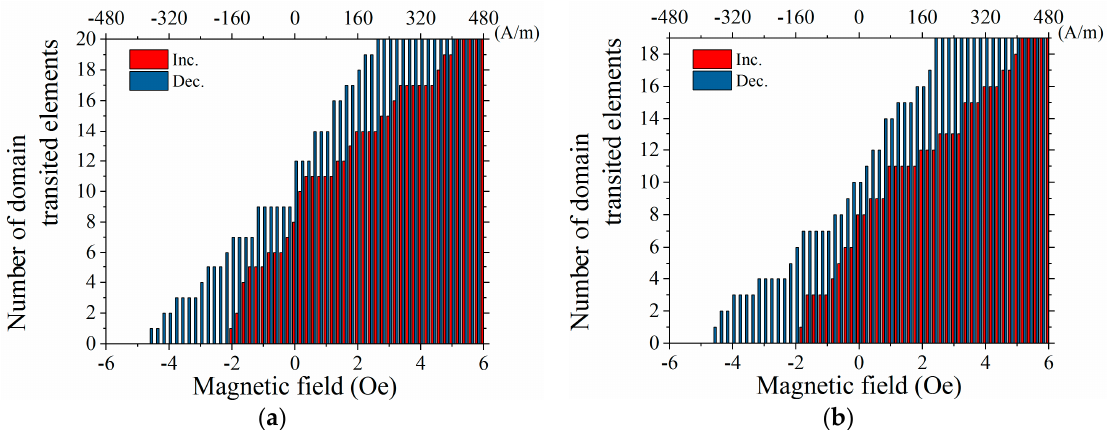
Figure 10. Number of domain transitions as a function of applied magnetic field. ( a ) The case for easy axis θ = 71 ° . ( b ) The case for easy axis θ = 90 ° .